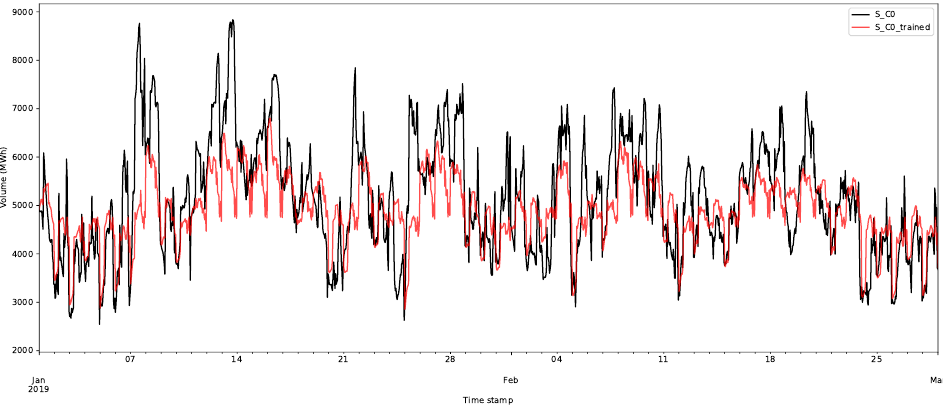
Figure 12. Day-ahead forecast for the first supply class for the first two months of the test set. The actual values are in black and the forecast values are in